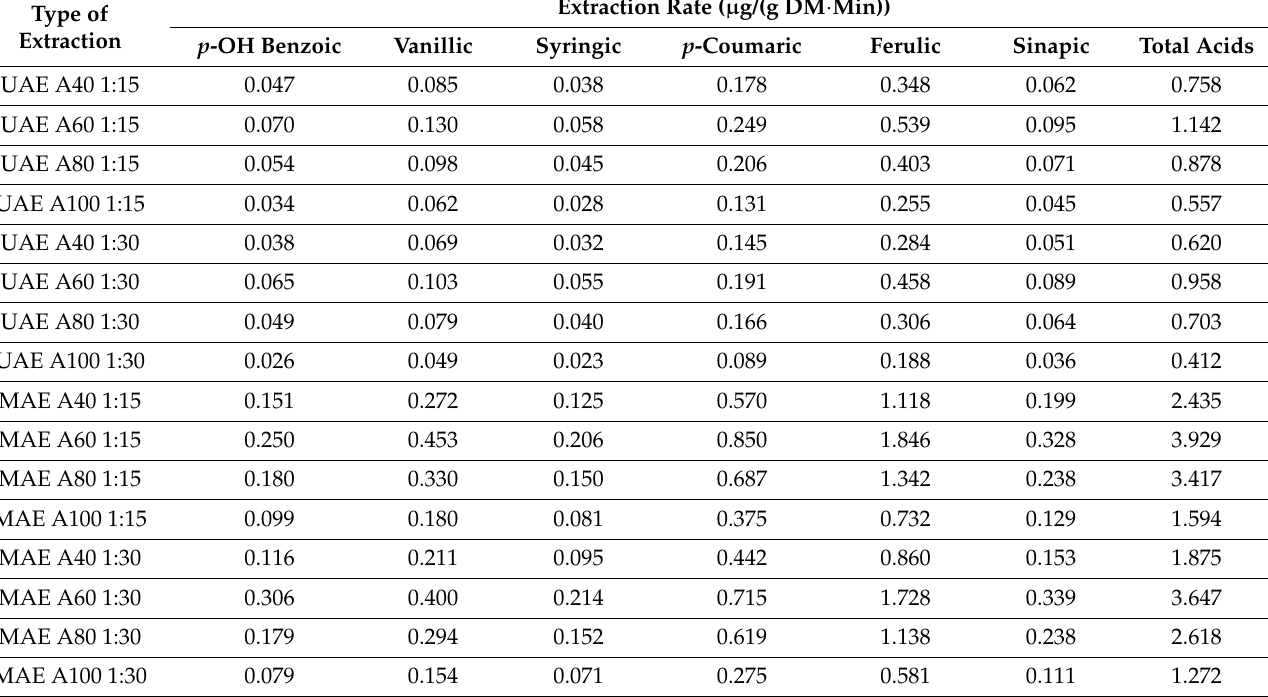
Table 3. Extraction rates for particular phenolic acids and the total phenolic acids. In the abbreviations used to refer to the series, the values after A show the solvent concentration; and finally, the solid-to- solvent ratio is